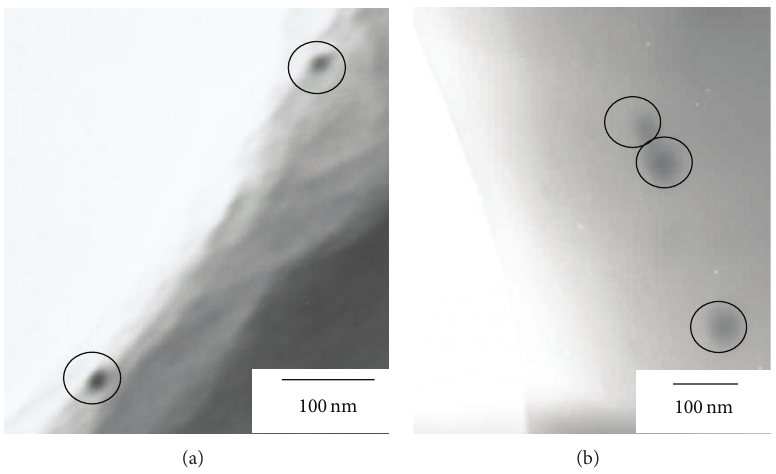
Figure 4: TEM image of composite films with (a) Cu/Ag = 0.1 and (b) Cu/Ag =